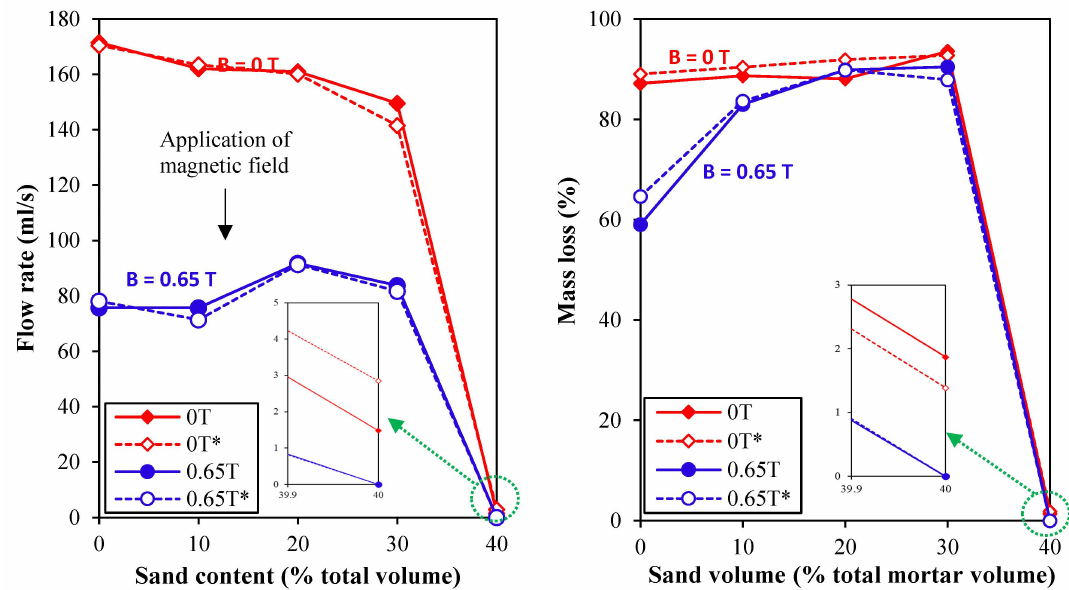
Figure 11. Effect of sand content on ( left ) mass flow rate, ( right ) mass loss (%). * Repetition of test on a different